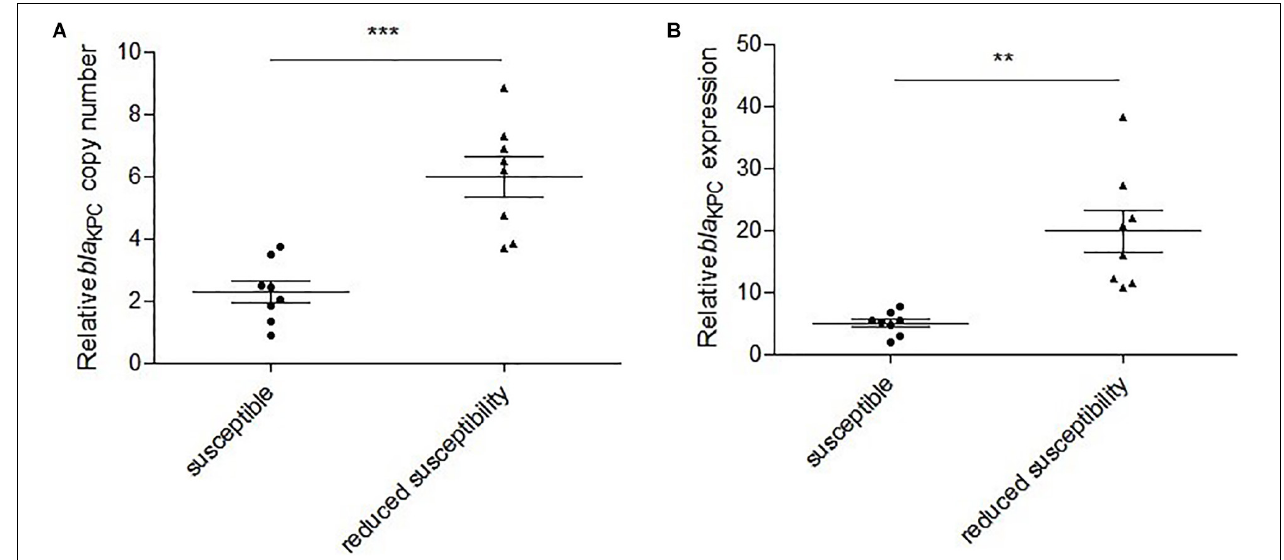
FIGURE 2 | Relative bla KPC − 2 copy numbers and expressions in susceptible and reduced susceptibility isolates. (A) Relative bla KPC − 2 copy numbers in selected isolates. *** P = 0.0004, Unpaired t test with Welch’s correction. (B) Relative bla KPC − 2 expressions in selected isolates. ** P = 0.0034, Unpaired t test with Welch’s